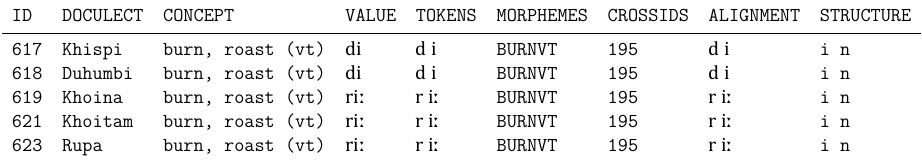
Table 3: Short example of the data and format employed in our